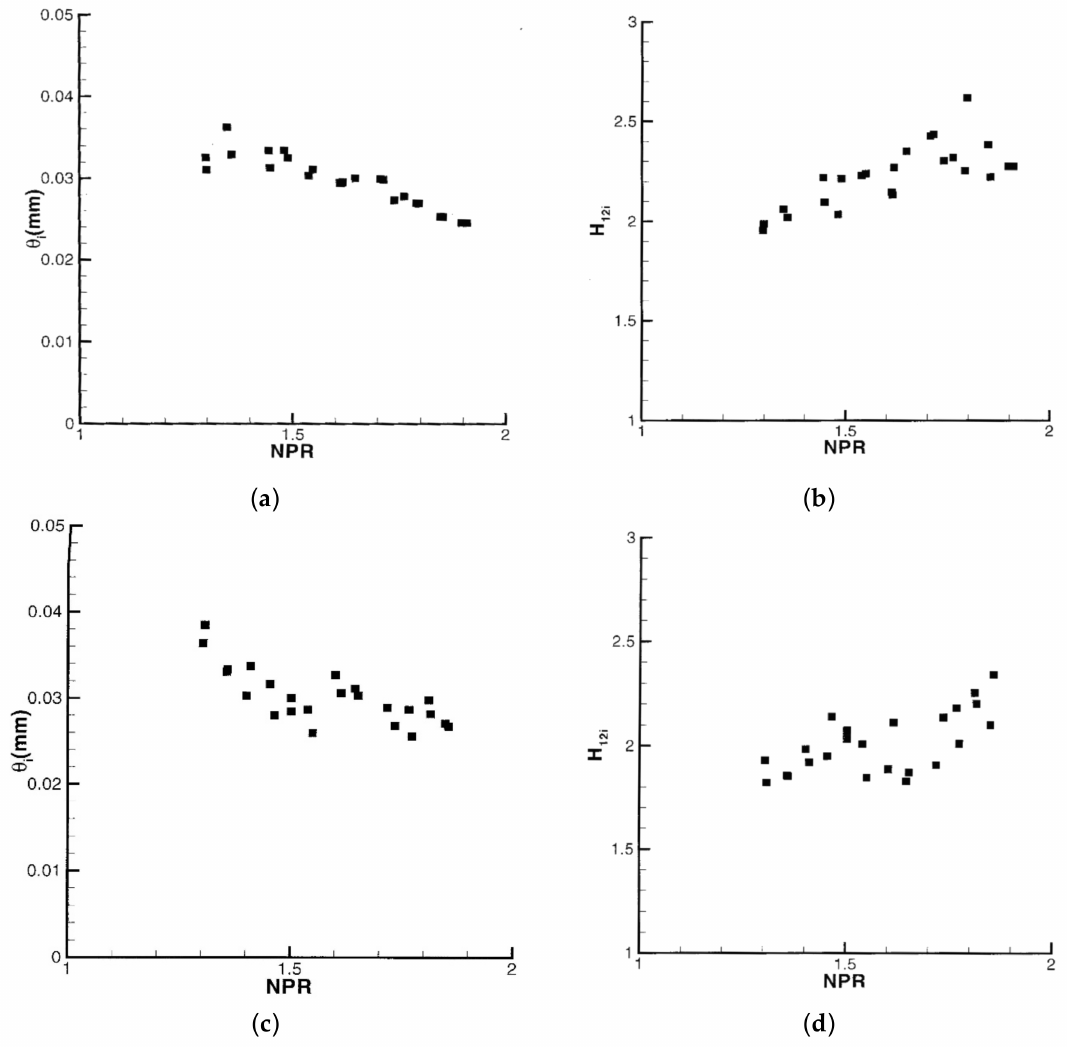
Figure 8. Probe-measured nozzle exit momentum thickness (left) and shape factor (right). ( a ) LU48, θ i ; ( b ) LU48, H 12 i ; ( c ) LU60, θ i ; ( d ) LU60, H 12 i